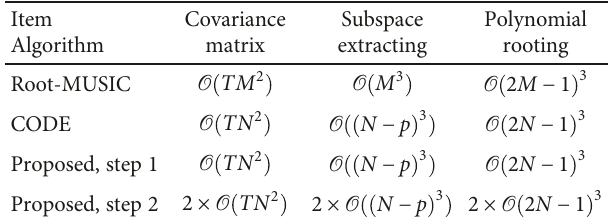
Table 2: Comparison of computational